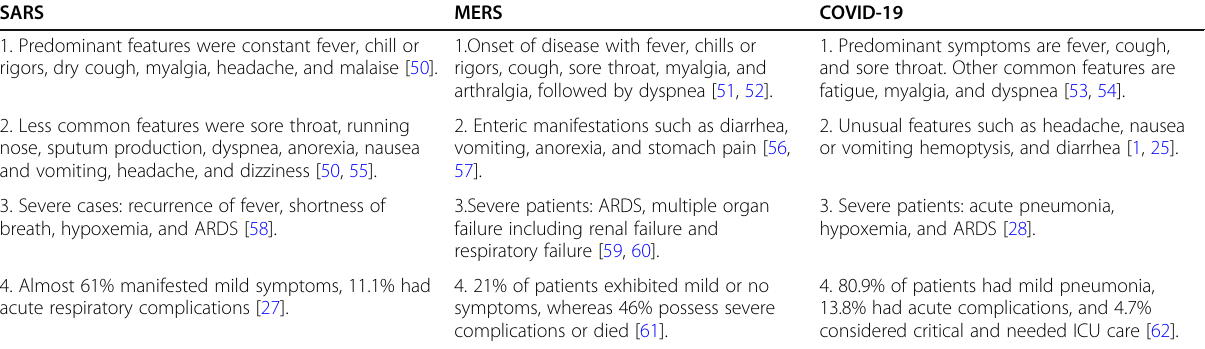
Table 2 Clinical features of SARS, MERS, and COVID-19